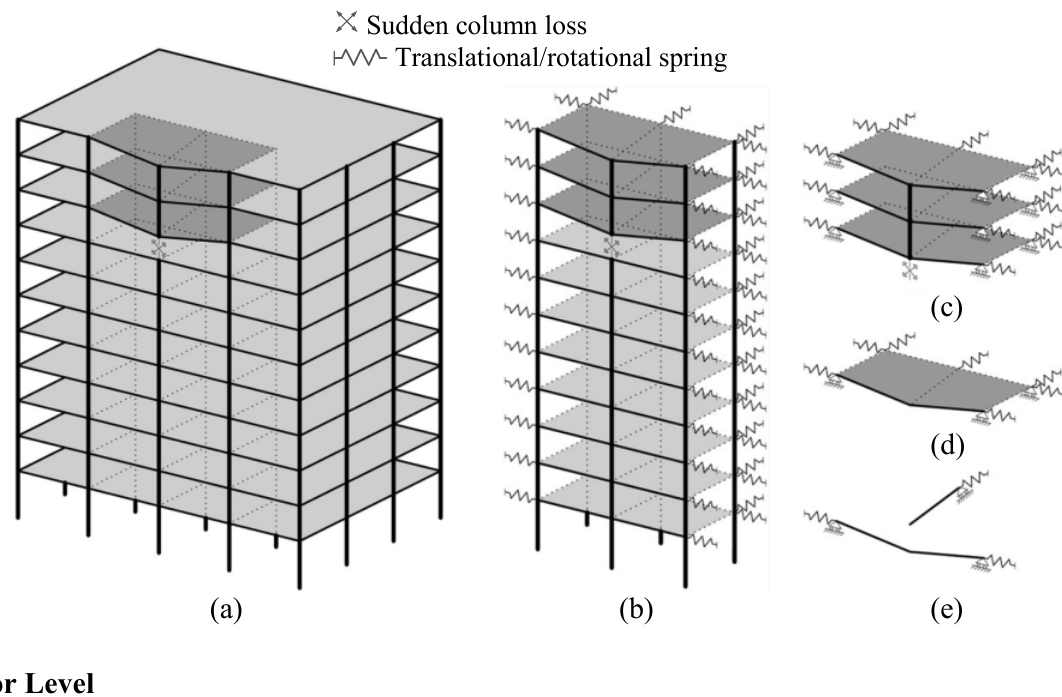
Figure 6. Structural idealization levels for column loss scenarios